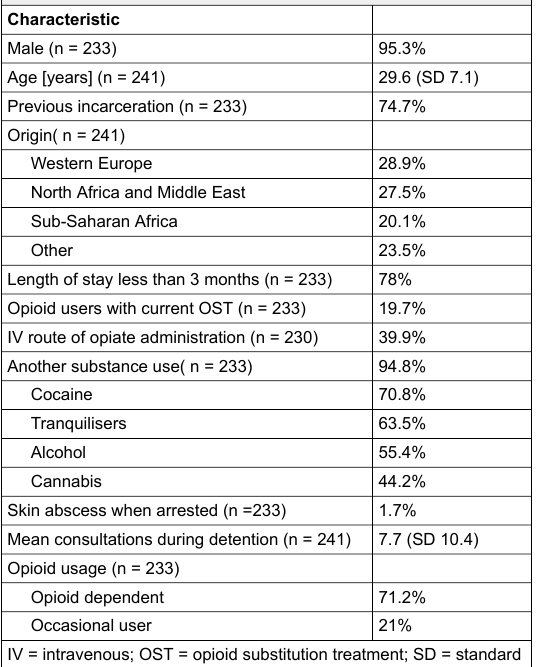
Table 2 : Baseline characteristics of opioid users in Geneva pretrial prison setting in 2007.